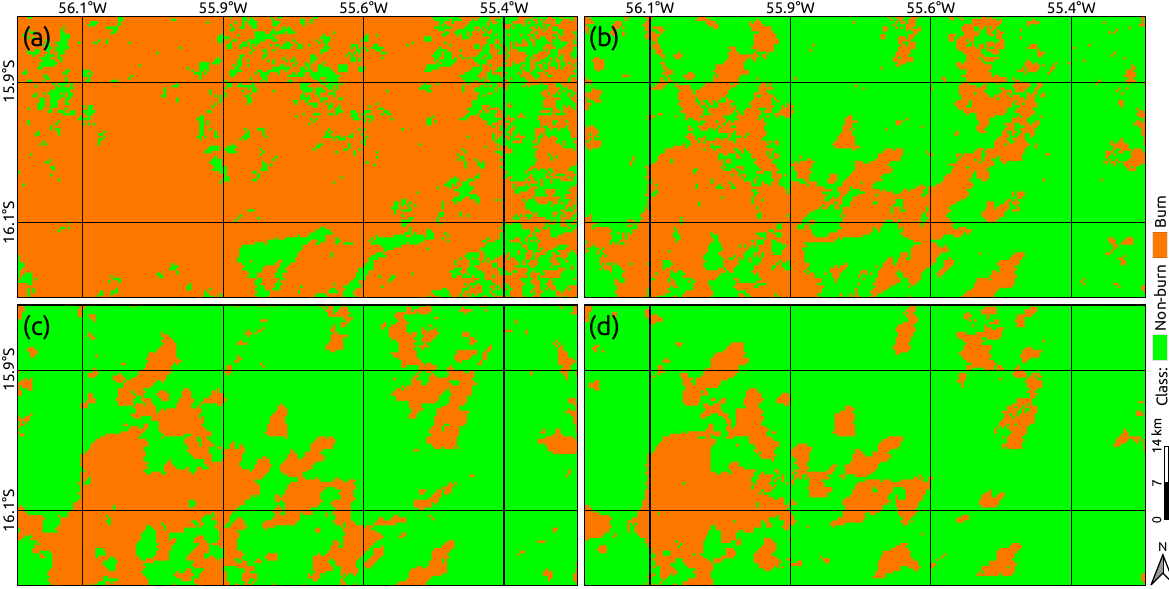
Figure 11. The mapping of fire-affected locations provided by the ( a ) MTDNBR, ( b ) GKM, and ( c ) UFD+MRF methods for Area 2 using MSI data. Estimates from the MBA product are shown in ( d ). Representations comprise the analyzed period of 1 August to 31 October 2020.